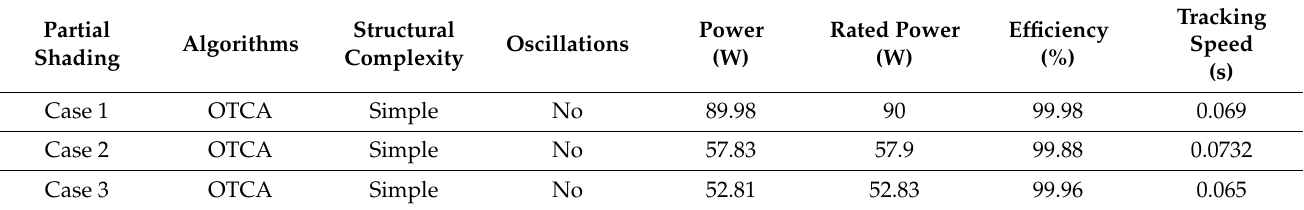
Table 8. Performance comparison of OTCA for 3S PV system for all test